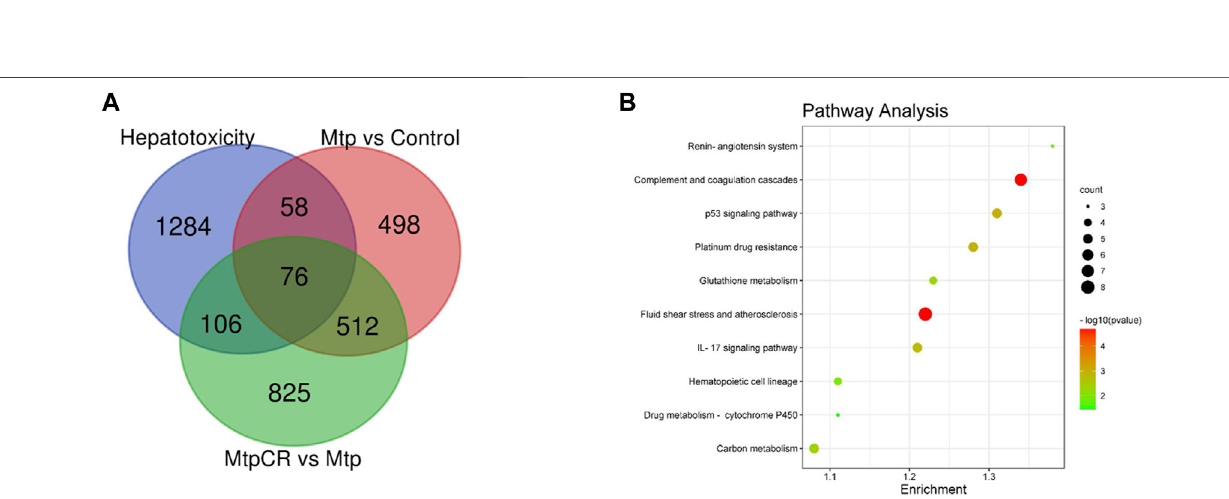
Frontiers in Pharmacology |